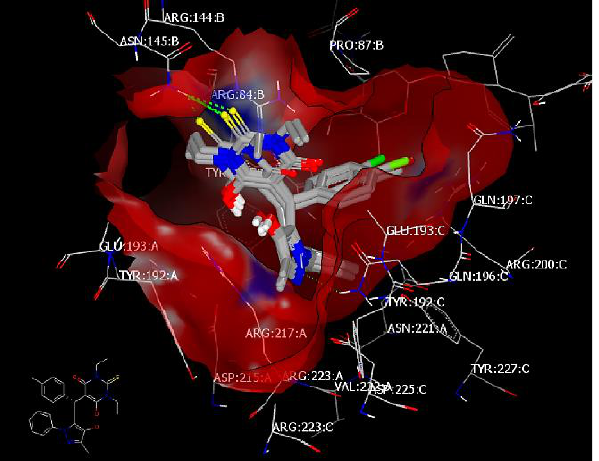
Figure 7. Visual representation of compound 61d docked with 4URM and overlay with 61c , 61a , and 61f . The compounds showed hydrogen bonding between the sulfur of the pyrimidine ring and ASN 145:A, as shown by Vida. Image adapted from Elshaier et al. [65].